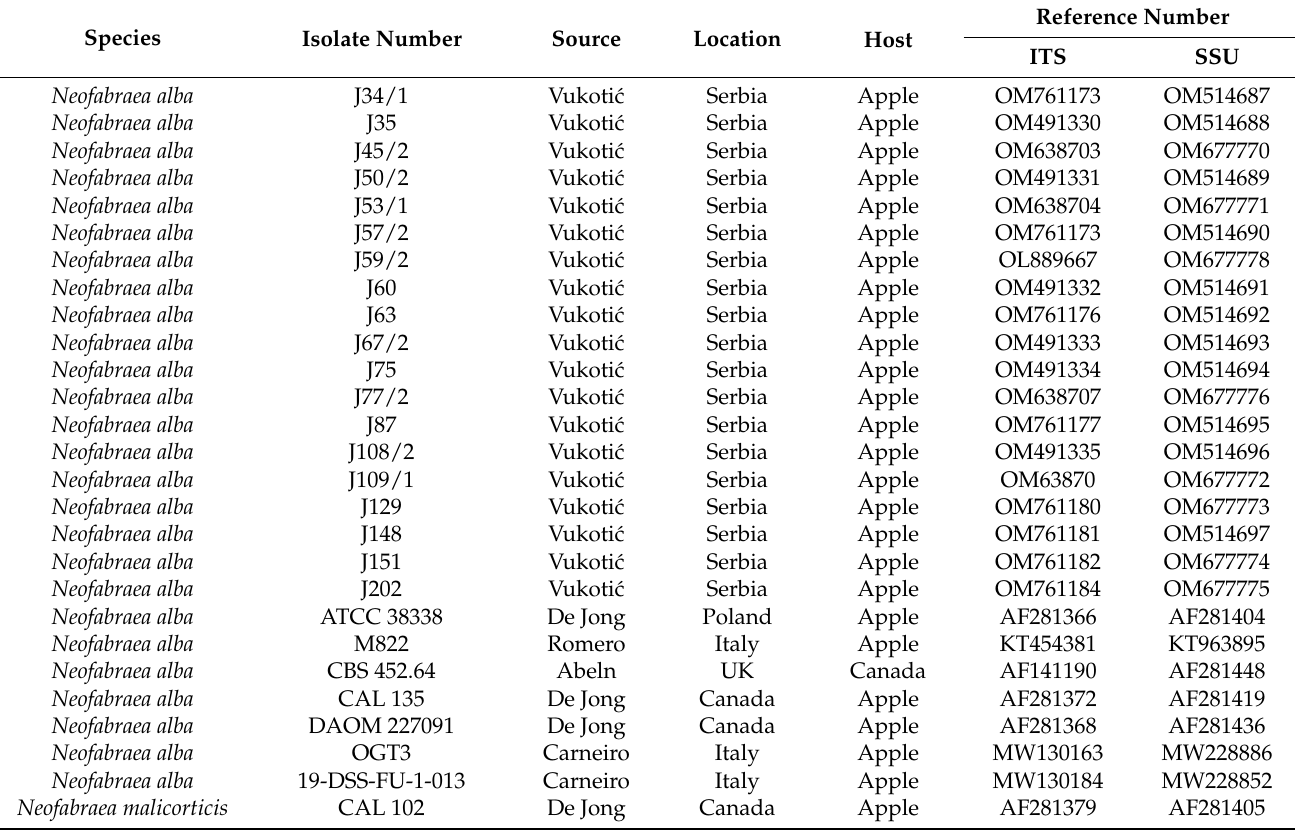
Table 1. Species of fungi used in phylogenetic analyses, including isolate number, source, location, host, and reference